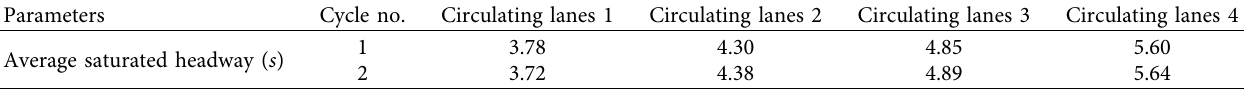
Table 4: Average saturated headway for circulating lanes in the merge area.